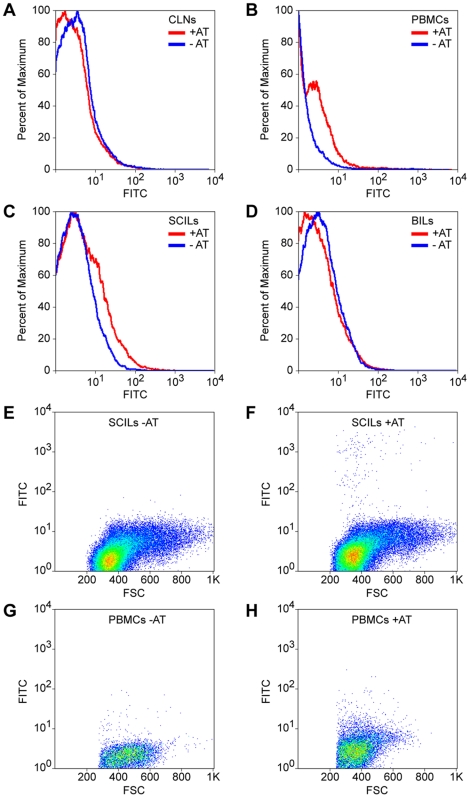
Adoptively transferred SCILs enter the spinal cord.CFSE-labeled SCILs are recovered from the blood (PBMCs) and spinal cord (SCILs) 60 min after adoptive transfer via tail vein injection. (A) Cervical lymph nodes (CLNs) did not contain green CFSE-labeled cells. (B) Green cells were recovered in the blood. (C) Green cells were also recovered from the spinal cord after adoptive transfer. (D) No labeled cells were found in the brain after transfer. (A–D) Red histograms represent the number of cell events observed in hosts that received adoptive transfer of CFSE-labeled SCILs while blue histograms represent control populations collected from mice that did not receive adoptive transfer. (E–H) Representative flow plots showing green cells isolated from the spinal cord (F) and blood (H) of hosts receiving CFSE-labeled SCILs, as compared to control spinal cord (E) and blood (G).